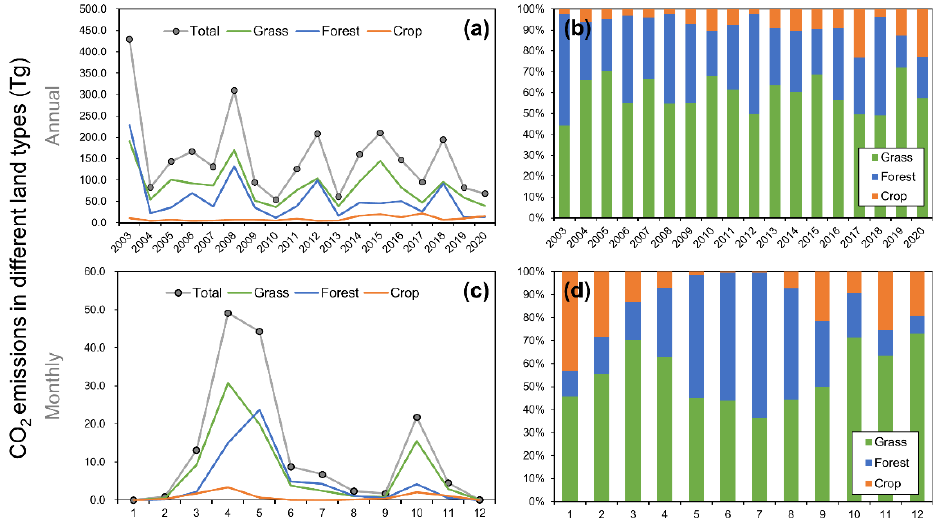
Figure 4. Annual and monthly CO 2 emissions from biomass burning in the Amur River Basin for 2003–2020 (unit: Tg). ( a , b ) Annual CO 2 emissions and contribution ratios to total emissions of different types of fires ; ( c , d ) Monthly CO 2 emissions and contribution rates to total emissions of different types of fires.